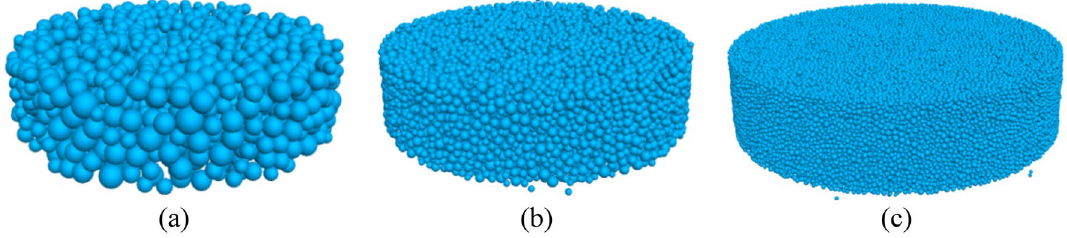
Figure 2. Samples with different particle diameters: ( a ) 4D, ( b ) 2D, ( c )